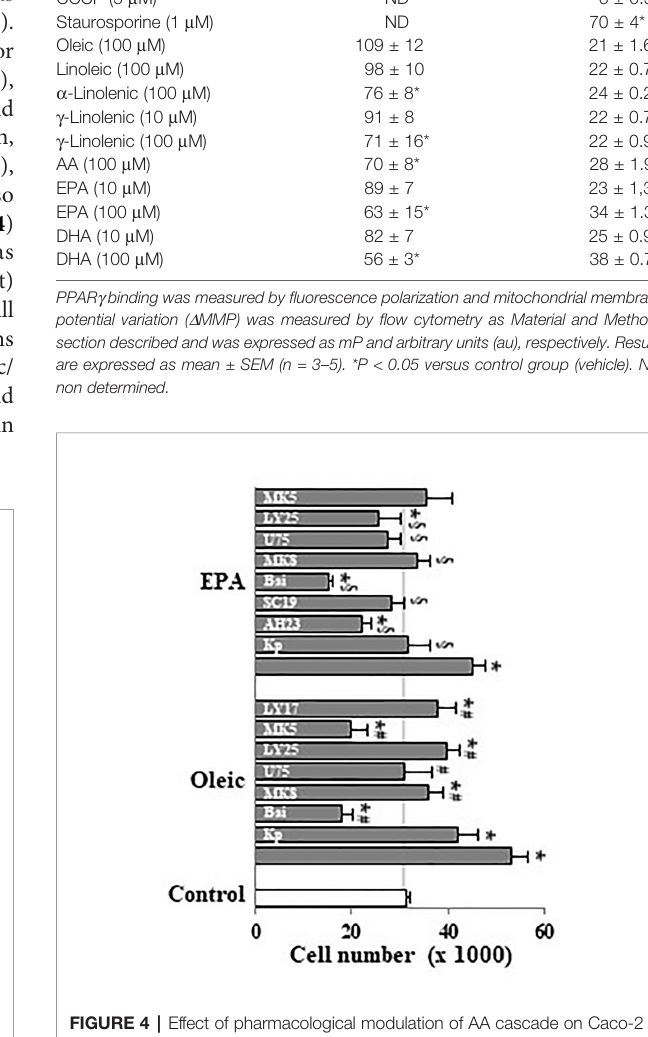
FIGURE 3 | Effect of different LCFA on Caco-2 cell apoptosis. Caco-2 cells were incubated with stearic, oleic, linoleic, a -linolenic, g -linolenic, AA, EPA, and DHA at 100 µM (black bars) in absence (A) or presence of FBS (B) for 48 h and DNA fragmentation was measured. Values are mean ± SEM (n = 3 – 8). *P < 0.05 versus negative control group (cells cultured in absence of FBS, white bar). As positive control we used staurosporine (1 µM) in presence of 10% FBS (white bar).